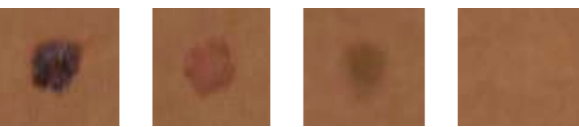
Figure 1: Different traces on cardboard in the RGB-display of the hyperspectral images. From left to right pure blood, diluted blood (1:16), pure semen, pure